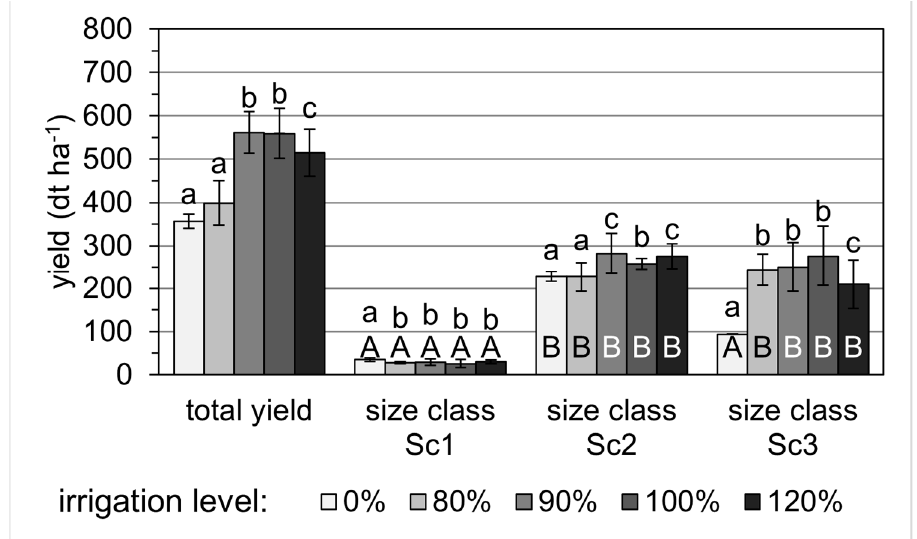
Figure 2. Total yield (dt ha − 1 ) per irrigation level (grey scale; 0% = 0 mm, 80% = 98.4 mm, 90% = 106.7 mm, 100% = 119.2 mm, 120% = 134.4 mm) as a sum of all tuber size classes and per tuber size class (S C 1: ≤ 35 mm; 35 mm < S C 2 ≤ 55 mm; S C 3: >55 mm) with standard deviation at 5% probability ( p ≤ 0.05). Lower case letters indicate statistically significant differences ( p ≤ 0.05) between irrigation levels within one tuber size class or total yield, respectively. Upper case letters indicate statistically significant differences ( p ≤ 0.05) between tuber size classes within one irrigation level.